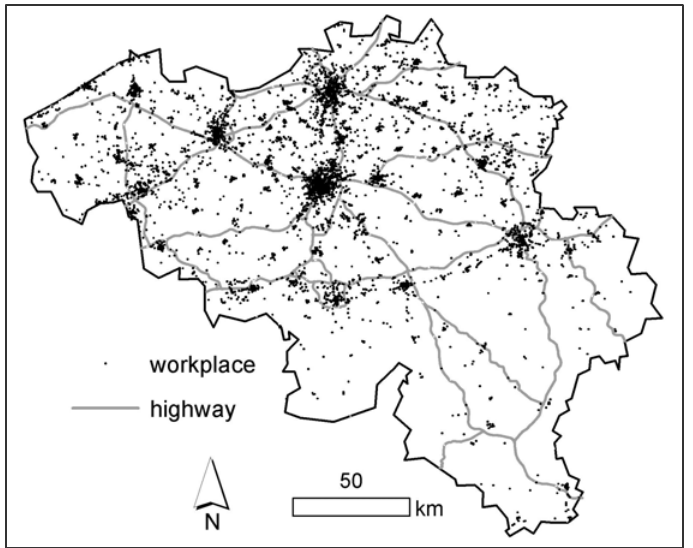
Figure 1. Locations of the workplaces in the Belgian database HTWT 2005 The renewed mobility policy focus on employers, strengthen the need for data at the workplace level. Common data sources, like the 2001 Belgian census (Verhetsel et al., 2010) and the Flemish regional travel survey ( Onderzoek Verplaatsingsgedrag Vlaanderen (OVG); Van Acker et al.,